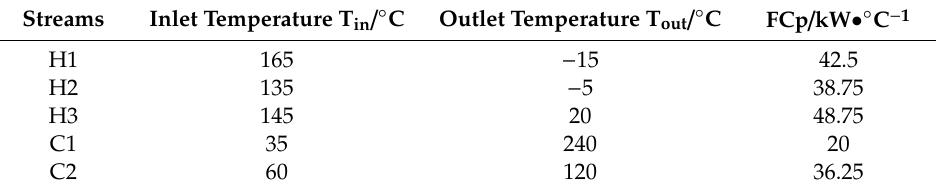
Table 2. Stream data for case